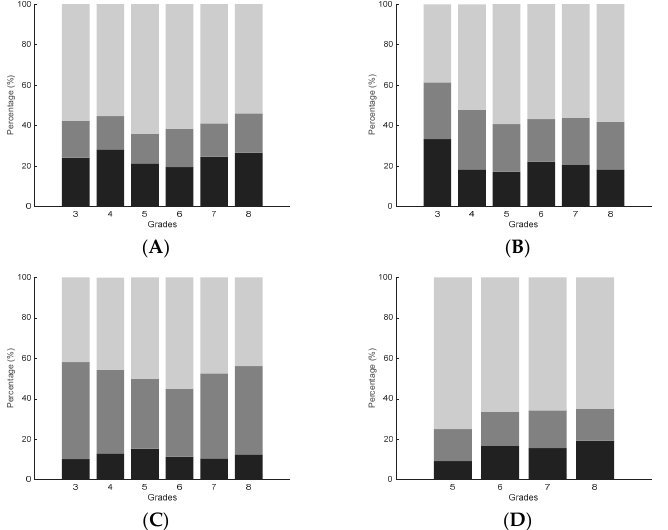
Figure 5. Percentages of children with positive (light grey), no (dark grey), or negative (black) development per grade. Results per panel: ( A ) walking backwards, ( B ) jumping sideways, ( C ) moving sideways, ( D ) eye hand coordination.